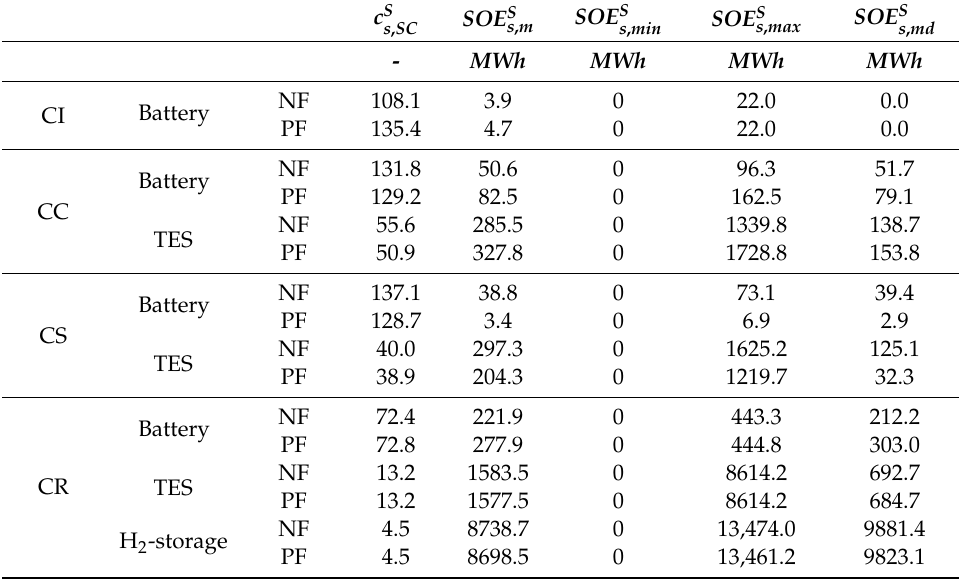
Table 8. Statistical analysis of the storages’ SOE time